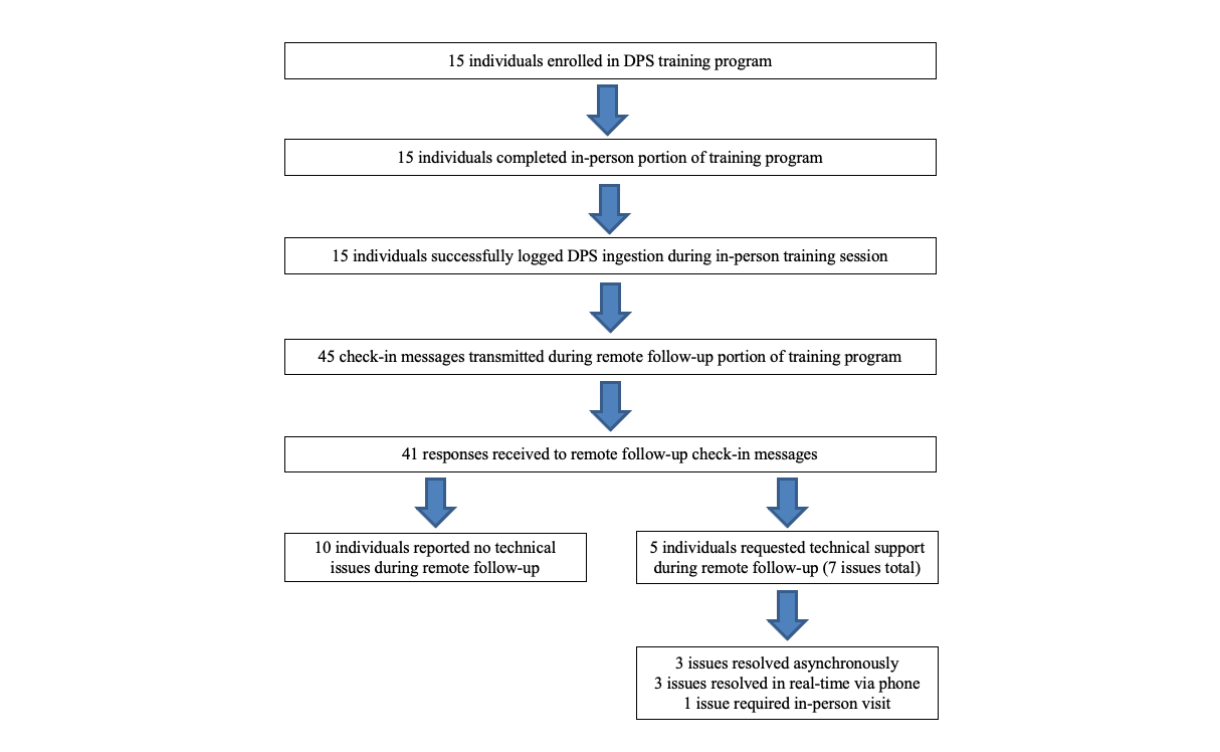
Figure 3. Participant enrollment and interaction with the digital pill system training program. DPS: digital pill system.